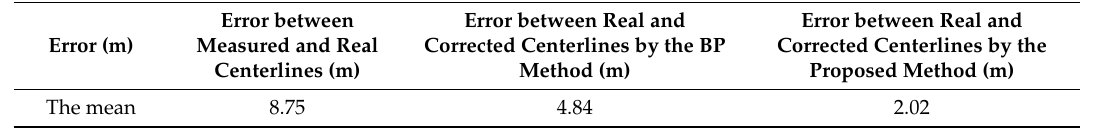
Table 4. Mean of absolute position error.